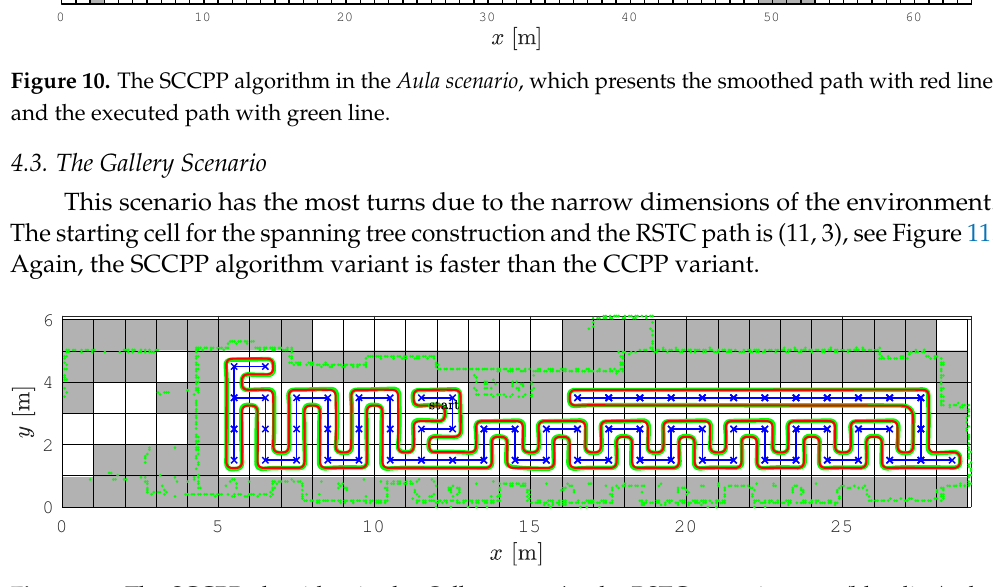
Figure 11. The SCCPP algorithm in the Gallery scenario : the RSTC spanning tree (blue line), the smoothed path (red line), and the executed path (green